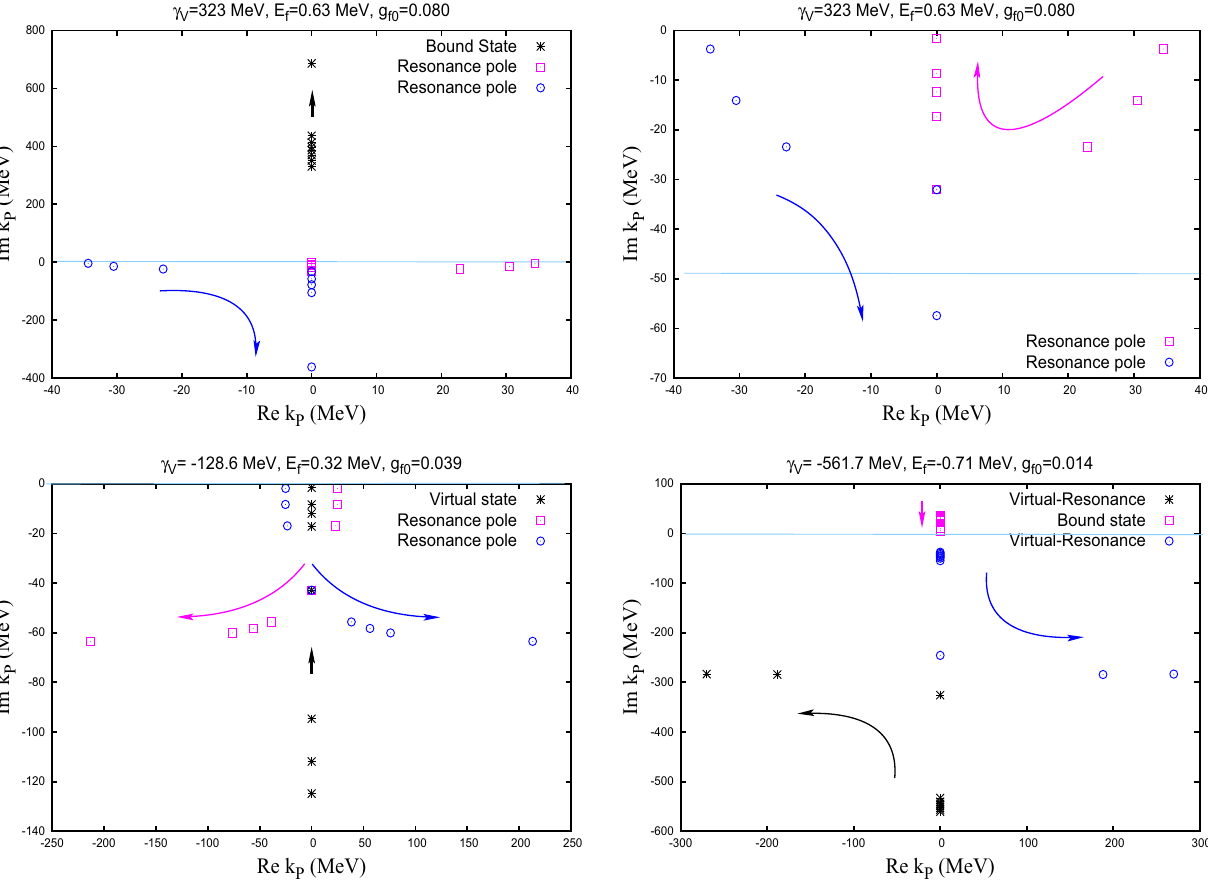
Fig. 6 Evolution of the poles as g f increases, with E f and γ V fixed. The top panels are for case 2.I, the bottom-left panel for case 2.II and the bottom-right one for case 3.II. In the right top panel a detail of the near-threshold region is given for case 2.I ¯ D ∗ 0 component is since for the former case the D 0